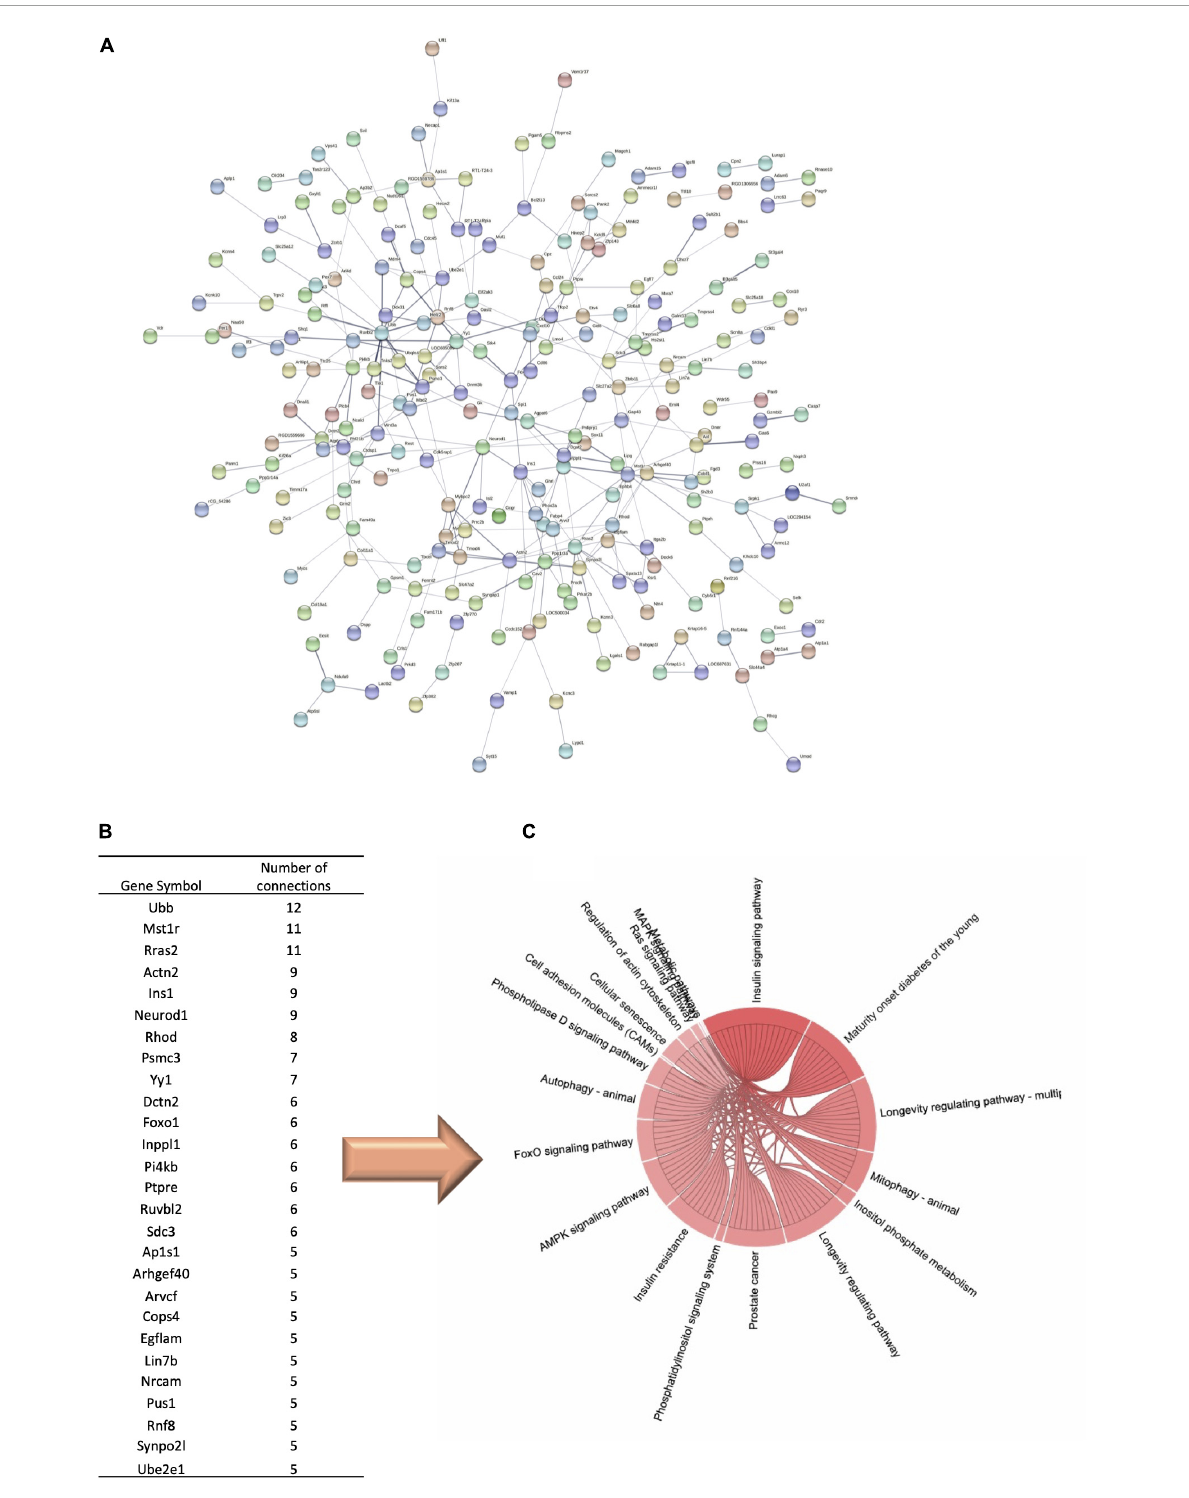
FIGURE5 Protein-protein interaction network. (A) Interactions between proteins encoded by genes modulated by anthocyanin-rich black beans extract supplementation in diabetic rats. (B) Top genes forming major interaction nodes in the network. (C) Pathway enrichment analyses of hub proteins encoded by